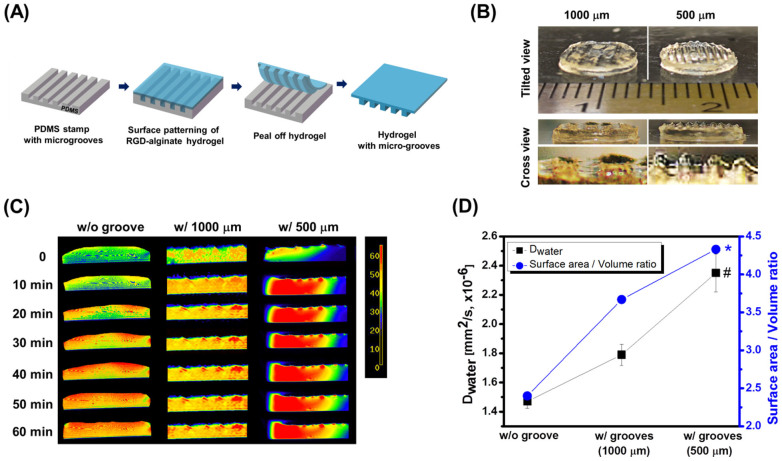
Computational simulation-guided assembly of microgrooved hydrogels.(A) The procedure to prepare the microgrooved hydrogel via in situ cross-linking reaction of alginate under a PDMS stamp. (B) Digital images of hydrogels with grooves of controlled spacing at 500 and 1,000 μm. (C) MR images of time-based water distribution in hydrogels. At time zero, 50 μl water was placed on top of the gel surface. The images were developed by averaging 2D image of multiple gel slices with width of 0.5 mm, along the axial plane. (D) Quantified analysis of the diffusivity of water (Dwater) in (left axis) and the surface area-to-volume ratio of (right axis) the hydrogels with controlled microgroove spacing. Data are mean ± SE, n = 5/condition (*,#p < 0.05).